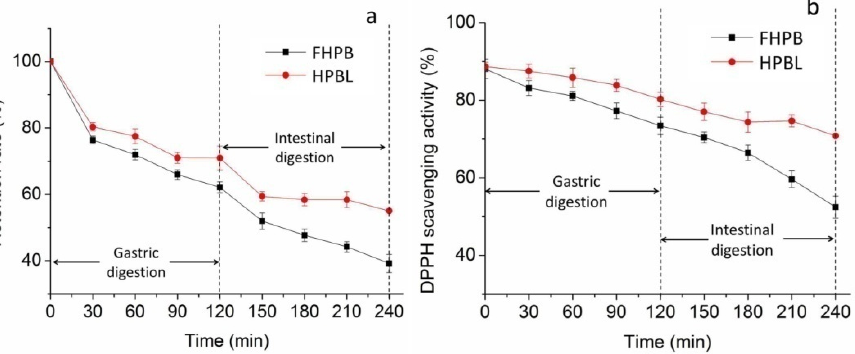
Figure 5. Stability of HPBL during in vitro gastrointestinal digestion: ( a ) Retention rate of HPBL during in vitro GI digestion; ( b ) variation of DPPH scavenging activity of HPBL during in vitro GI digestion.